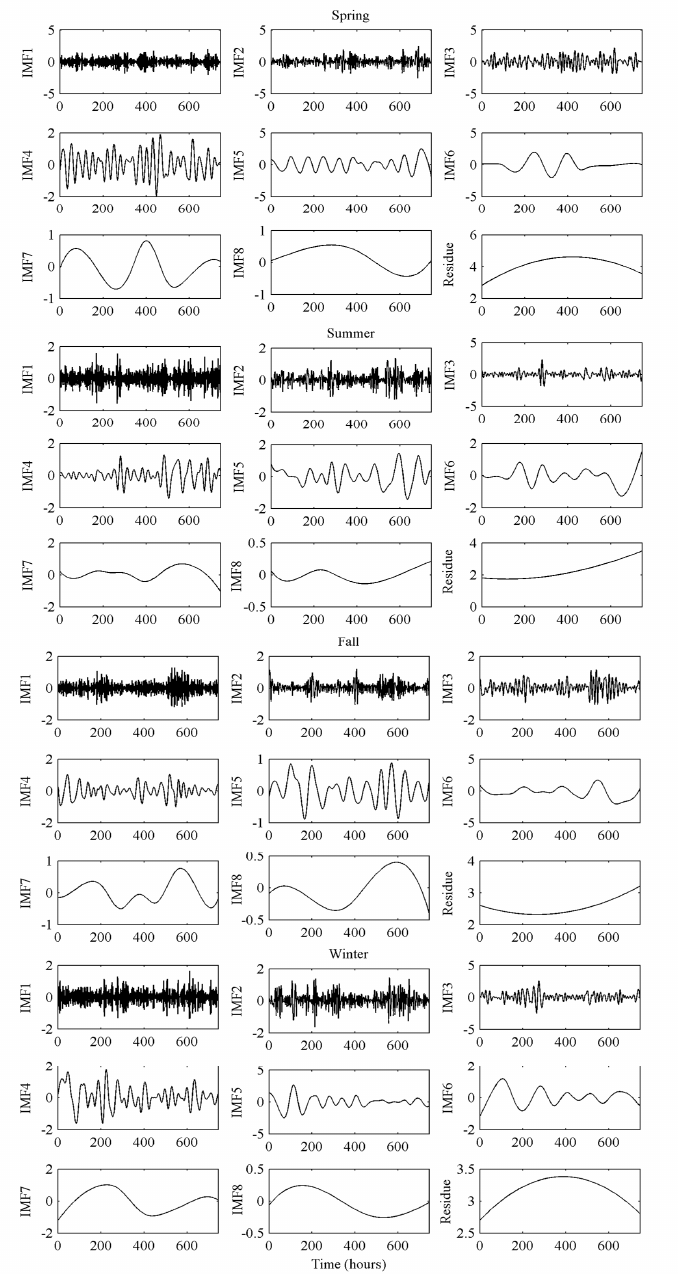
Figure 5. The decomposed results of trend components using FEEMD in four cases.